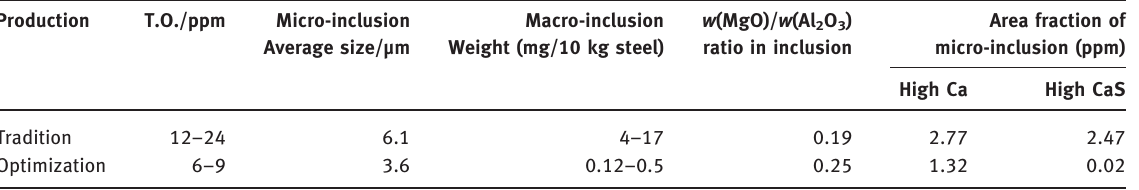
Table 4: Cleanliness of rod drill before and after optimization. Production